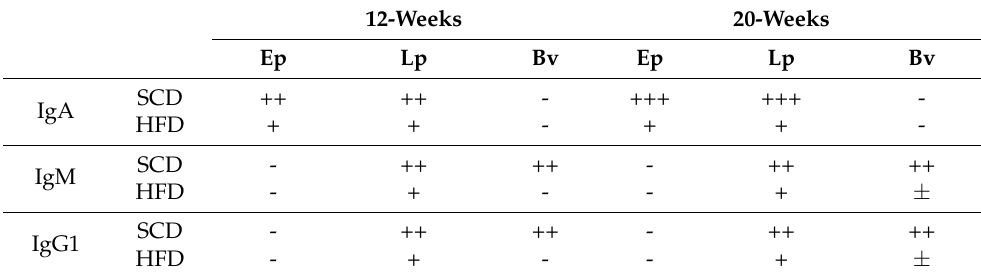
Table 1. Semi-quantification of Immunoglobulins in small intestinal villi. 12-Weeks